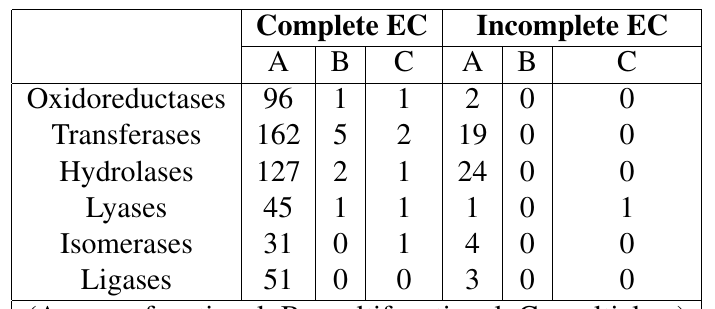
Table 3: Enzyme encoding genes classification